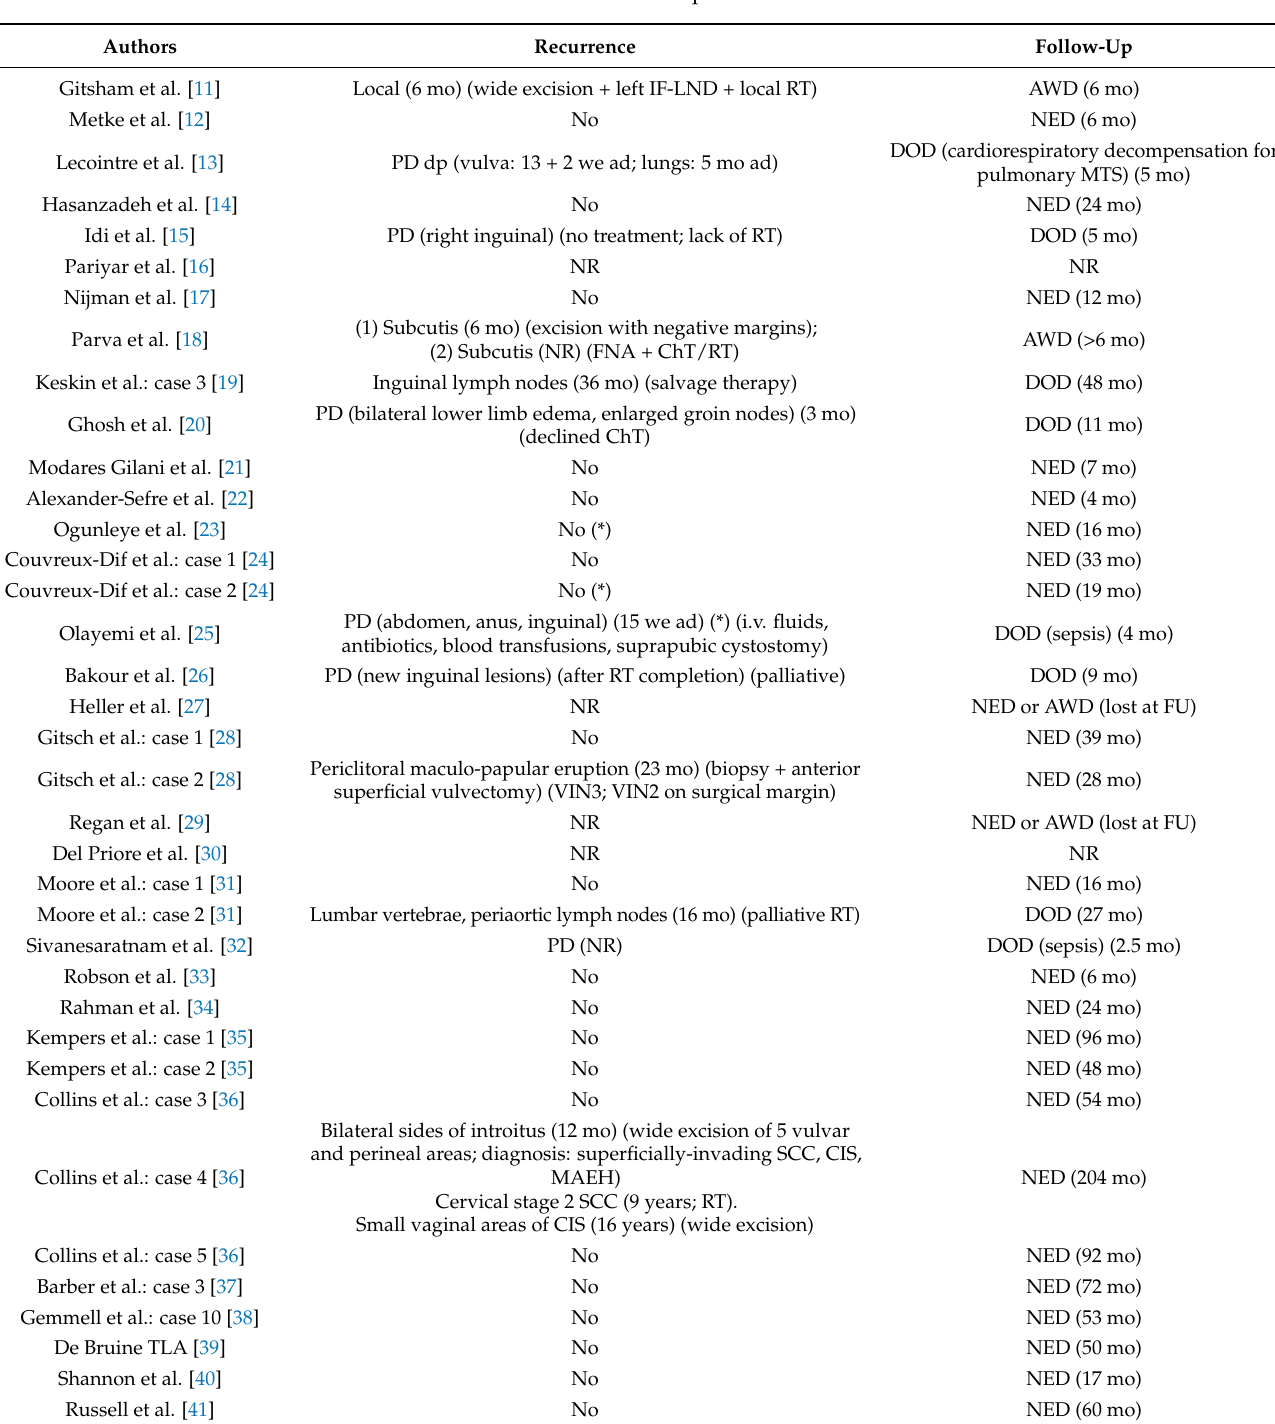
Table 3. Follow-up